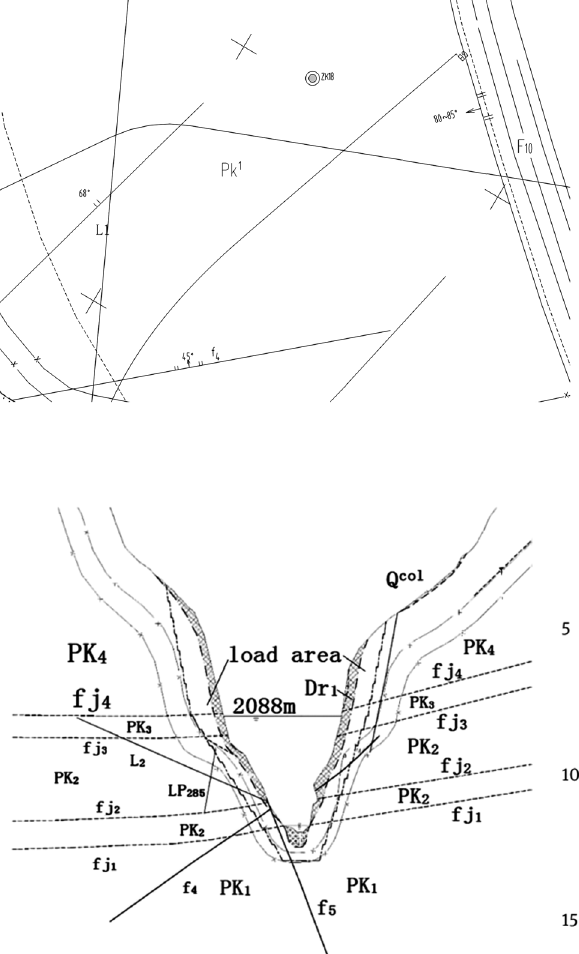
Figure 2: Engineering geology section view of Lizhou hydropower station.